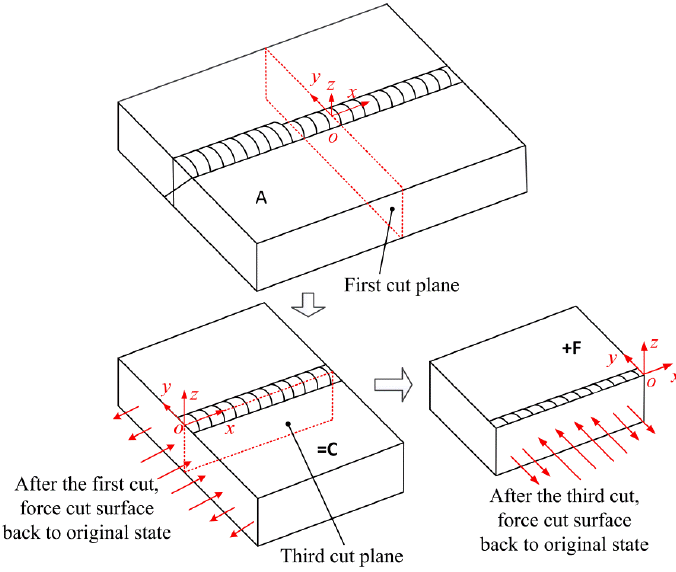
Figure 5. Superposition principle to get the original transverse stress along the plane of the third cut plane.